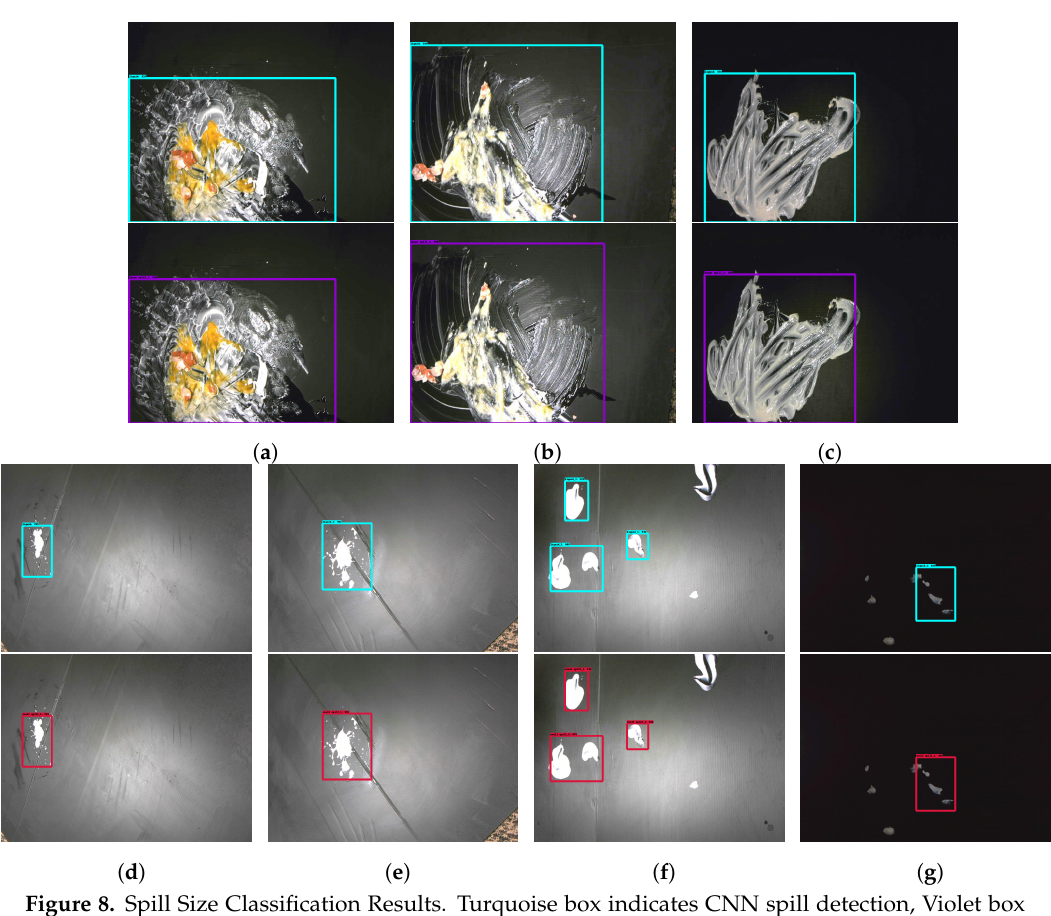
Figure 8. Spill Size Classification Results. Turquoise box indicates CNN spill detection, Violet box indicates large spillage debris and red indicates small spillage debris. All areas are in cm 2 . ( a ) Area: 1167.4; ( b ) Area: 1461.2; ( c ) Area: 888.8; ( d ) Area: 75.4; ( e ) Area: 158.4; ( f ) Area: 28.3, 111.3, 54.9; ( g ) Area: